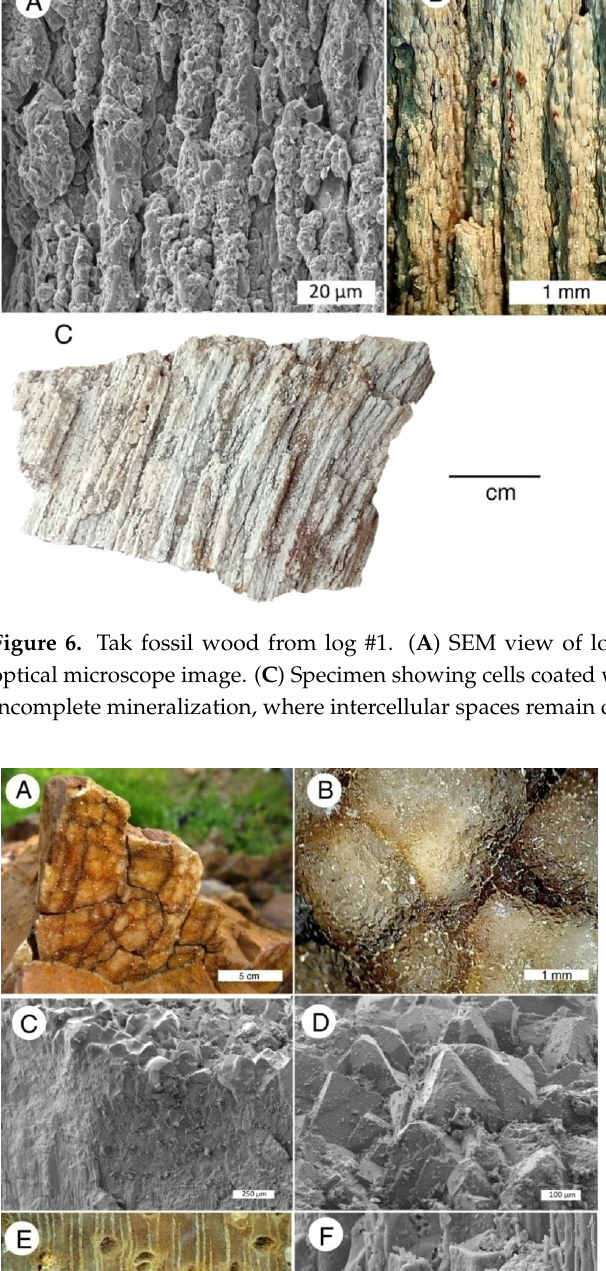
Figure 5. Thin-section images of fossil wood from Tak fossil forest showing vessels lined with quartz crystals, with the central area remaining open. For each pair, the image on the left is illuminated with ordinary transmitted light; the image on right was made with cross-polarized